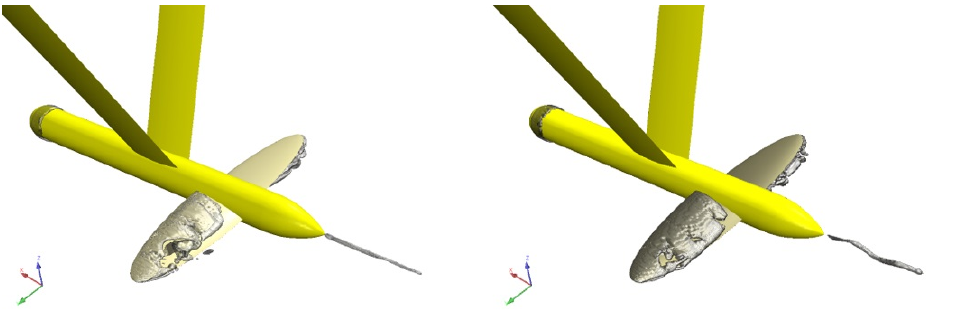
Figure 18. Snapshots of the CFD simulations by VOF ( left ) and EE ( right ) multiphase flow models. Animation file demonstrating the cavitation dynamics is provided as Supplementary Material (Video S1) to this